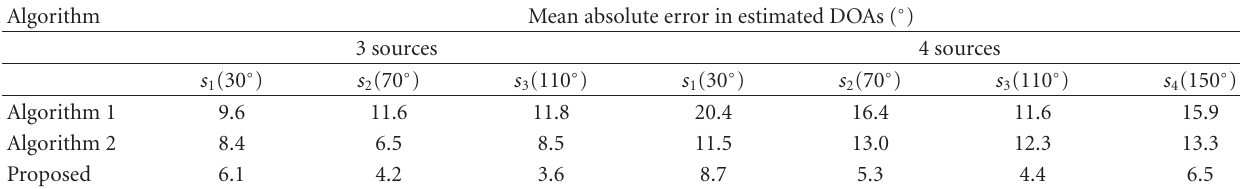
Figure 3: Histogram of the di ff erences between the variances (left) and kurtoses (right) of the dominant and the weakest source (for the case of three sources) (a) and of the dominant and the second weakest source (for the case of four sources) (b). Table 1: Mean absolute error in estimated DOAs (in degrees) obtained by the proposed algorithm and the previous algorithms when two microphones are used and three/four sources are